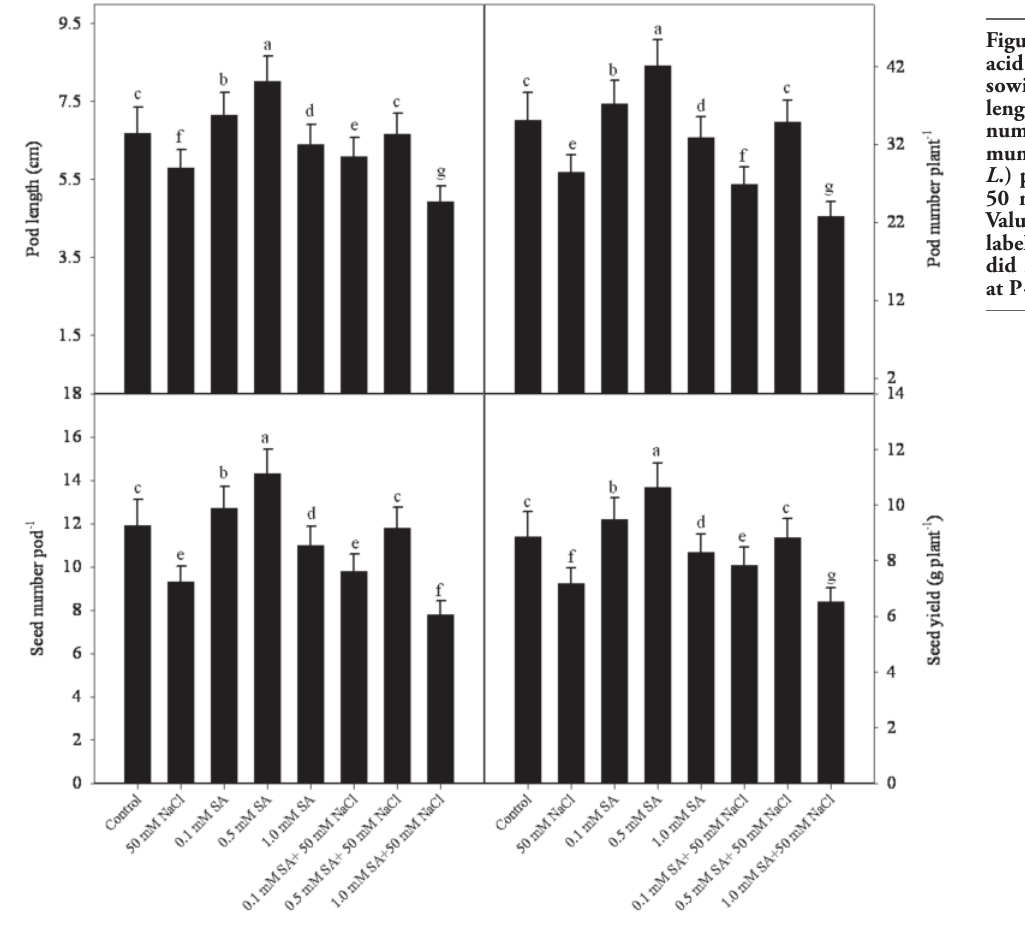
Figure 7. Effect of salicylic acid spray at 15 days after sowing (DAS) on pod length, pod number, seed number, and seed yield of mungbean ( Vigna radiata L. ) plants grown with 0 or 50 mM NaCl at 30 DAS. Values are mean±SE. Data labeled by the same letter did not differ significantly at